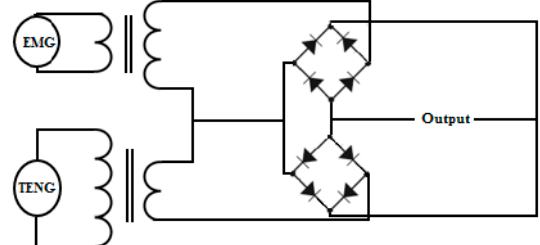
Figure 15. Circuit diagram of the connection mechanism of TENG and EMG.